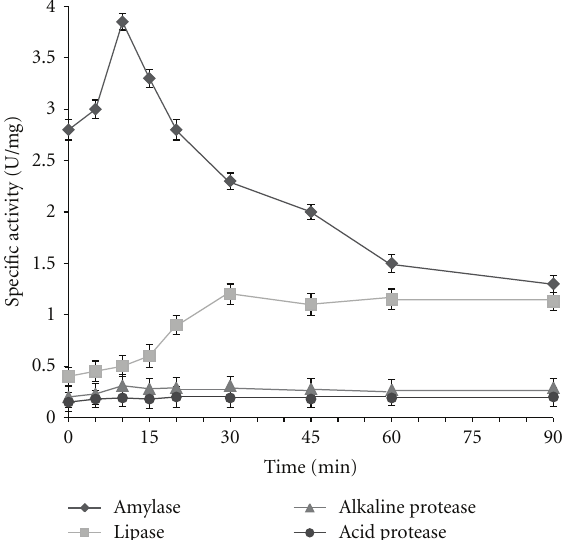
Figure 3: E ff ect of incubation times on the activity of amylase, lipase, alkaline, and acid proteases in the hepatopancreas of crayfish Cherax albidus juveniles. Gastric juice and intestine gave similar results. Valuesare reported as means ± SEM. Assayswere performed on three samples in duplicate.